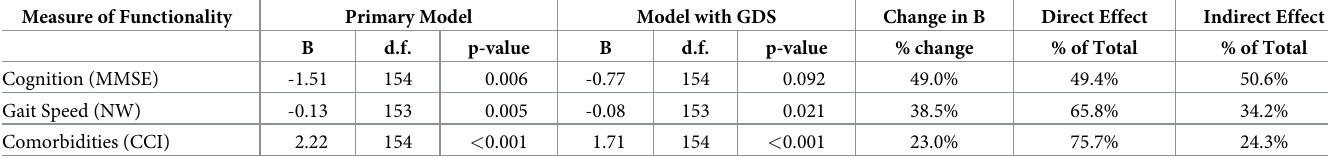
Table 2. Mediation effect of depression on the relationship between gait speed, cognition, and medical comorbidities on disability.